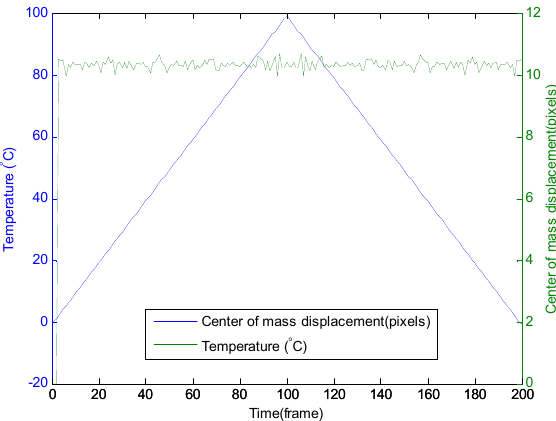
Figure 5. Displacement of the center of gravity of the interference pattern with the temperature variation from 0 °C to 100 °C and then from 100 °C to 0 °C.